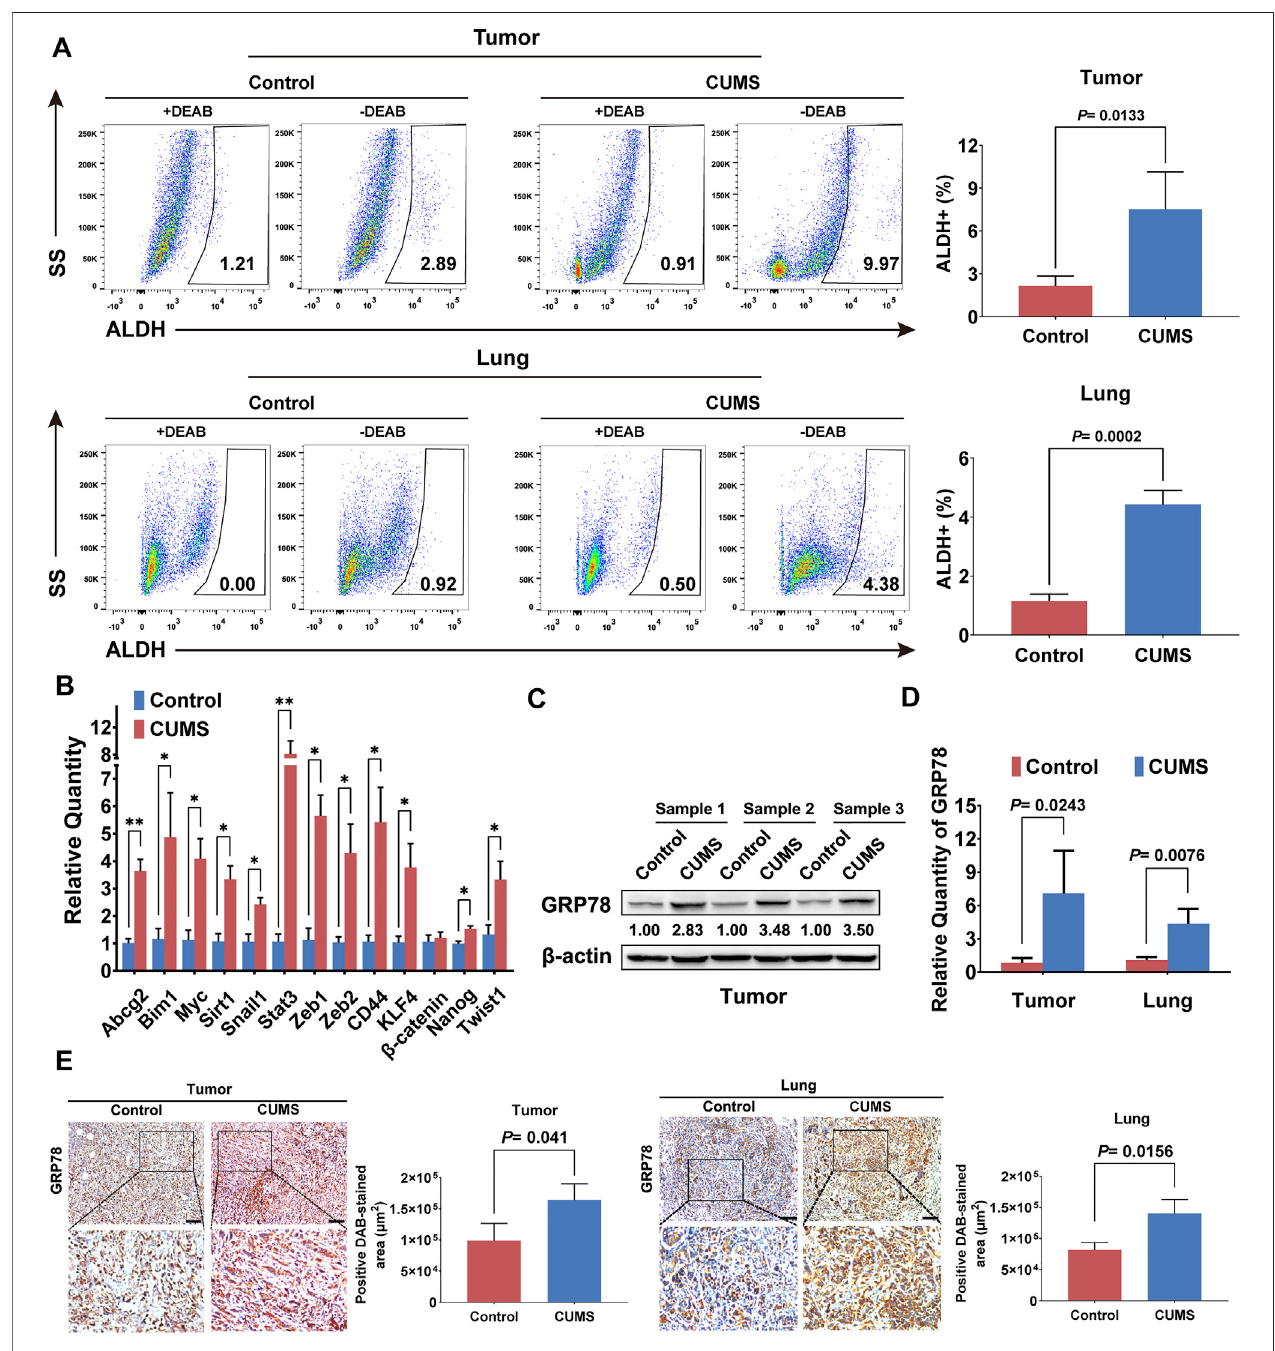
FIGURE 2 | CUMS enhances GRP78 expression and breast cancer stemness in 4T1 tumor-bearing mice. (A) ALDH + cells were analyzed by fl ow cytometry to compare the stem cell-like populations in primary tumor and lung metastatic lesions between the CUMS-treated and non-treated 4T1 tumor-bearing mice. DEAB, a speci fi cinhibitorofALDHactivity,wasusedtocontrolthebackground fl uorescence. (B) Stem-relatedgeneexpressioninthebreasttumorsunderCUMSwascompared withthoseinthe non-treated mice byqPCR. (C) GRP78expression inthe primary tumors ofthemice underCUMS wasdetected bywesternblots. (D) The mRNA levelofGRP78intheprimaryandmetastaticlesions. (E) ExpressionofGRP78intheprimaryandlungmetastaticlesionsintheCUMSandcontrolgroupswasmeasured by immunohistochemistry (n (cid:2) 8, the scale bars indicate 100 μ m). Data are represented as the mean value ± SD. One representative experiment of three independent experiments is displayed. Unpaired two-sided Student ’ s t-tests were applied, *p < 0.05, **p < 0.01.